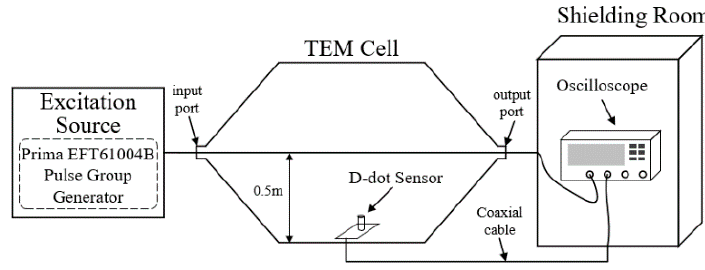
Figure 3. Schematic of calibration platform for D-dot sensors.